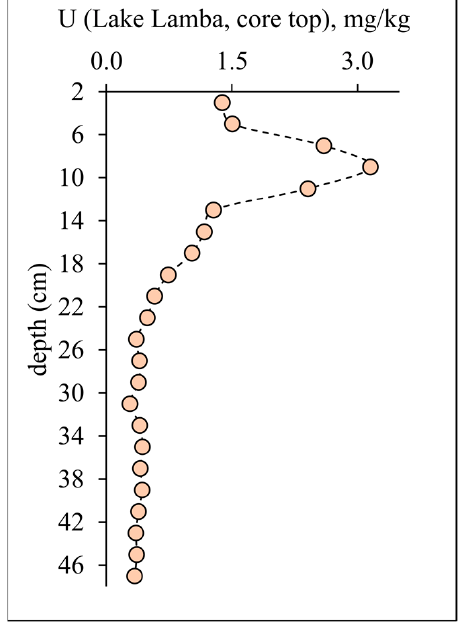
Figure 11. Vertical distribution of U in the sediments of Lake Lamba (Petrozavodsk).